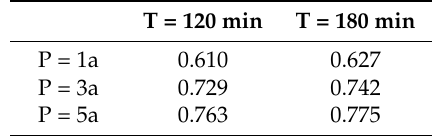
Table 3. Comprehensive runoff coefficient in various conditions.